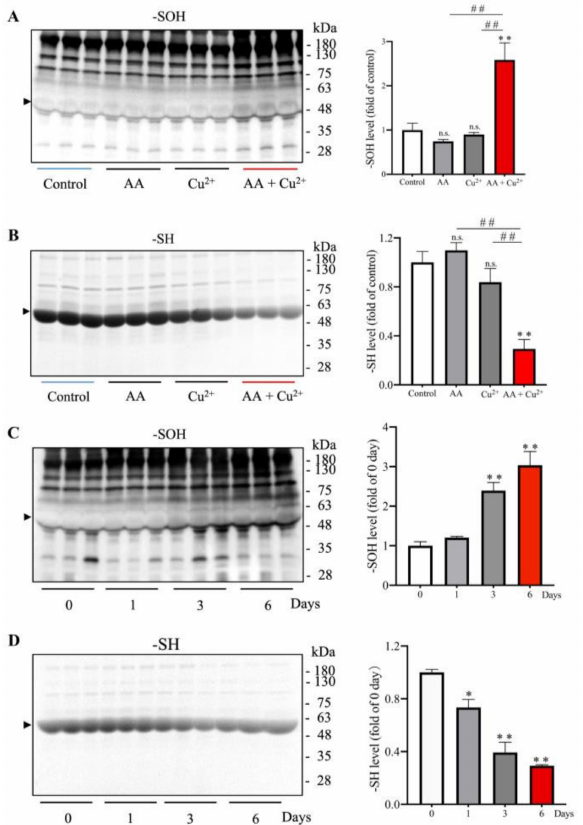
Figure 1. Effects of the in vivo administration of ascorbic acid (AA) and copper (Cu 2+ ) on the oxidative status of -SH groups in serum proteins. ( A , B ) Mice were administered 100 mg/kg AA or 1 mg/kg Cu 2+ or both in combination via oral gavage once a day for five consecutive days. ( C , D ) Mice were administered with AA plus Cu 2+ for the indicated time. Serum proteins were analyzed for the level of sulfhydryl groups (-SH) and sulfenic acids (-SOH) formation. The densitometric quantitation of the bands around 50~60 kDa (arrowhead) were performed and presented as the bar graph on the right side of the blot. Data shown are mean ± SE ( n = 3–4; n.s.: not significant; * p < 0.05; ** p < 0.01 vs. control; ## p <